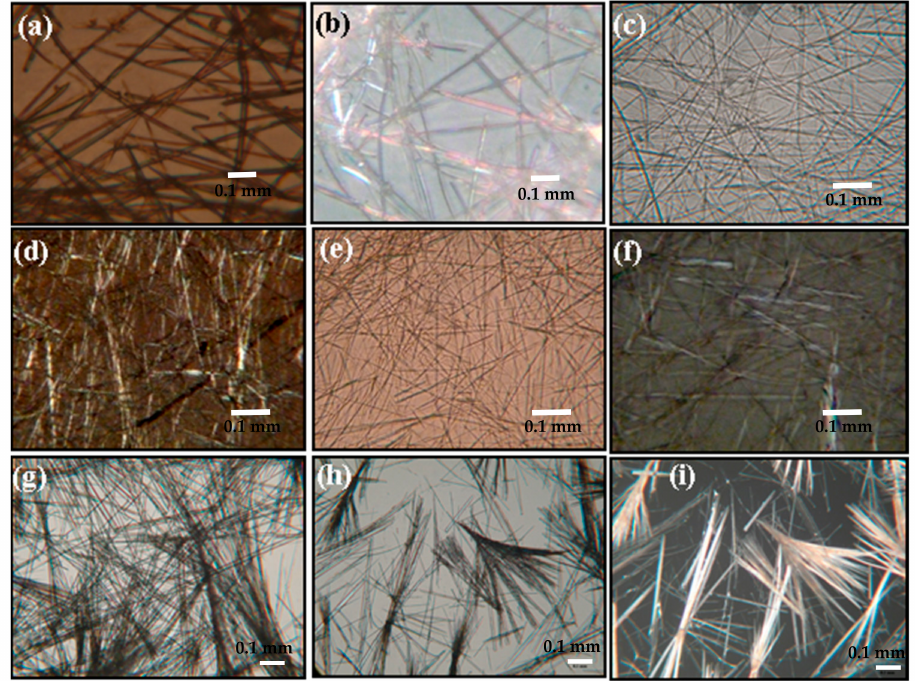
Figure 2. Optical microscopic images of ( a ) MEM:TPCA 1:1, ( c ) MM:TPCA 1:1, ( e ) MM:BTA 1:1, ( g ) MM:CHTA 1:1, ( h ) MM:CHTA 1:3 and polarized optical microscopic images of ( b ) MEM:TPCA 1:1, ( d ) MM:TPCA 1:1, ( f ) MM:BTA 1:1, ( i ) MM:CHTA